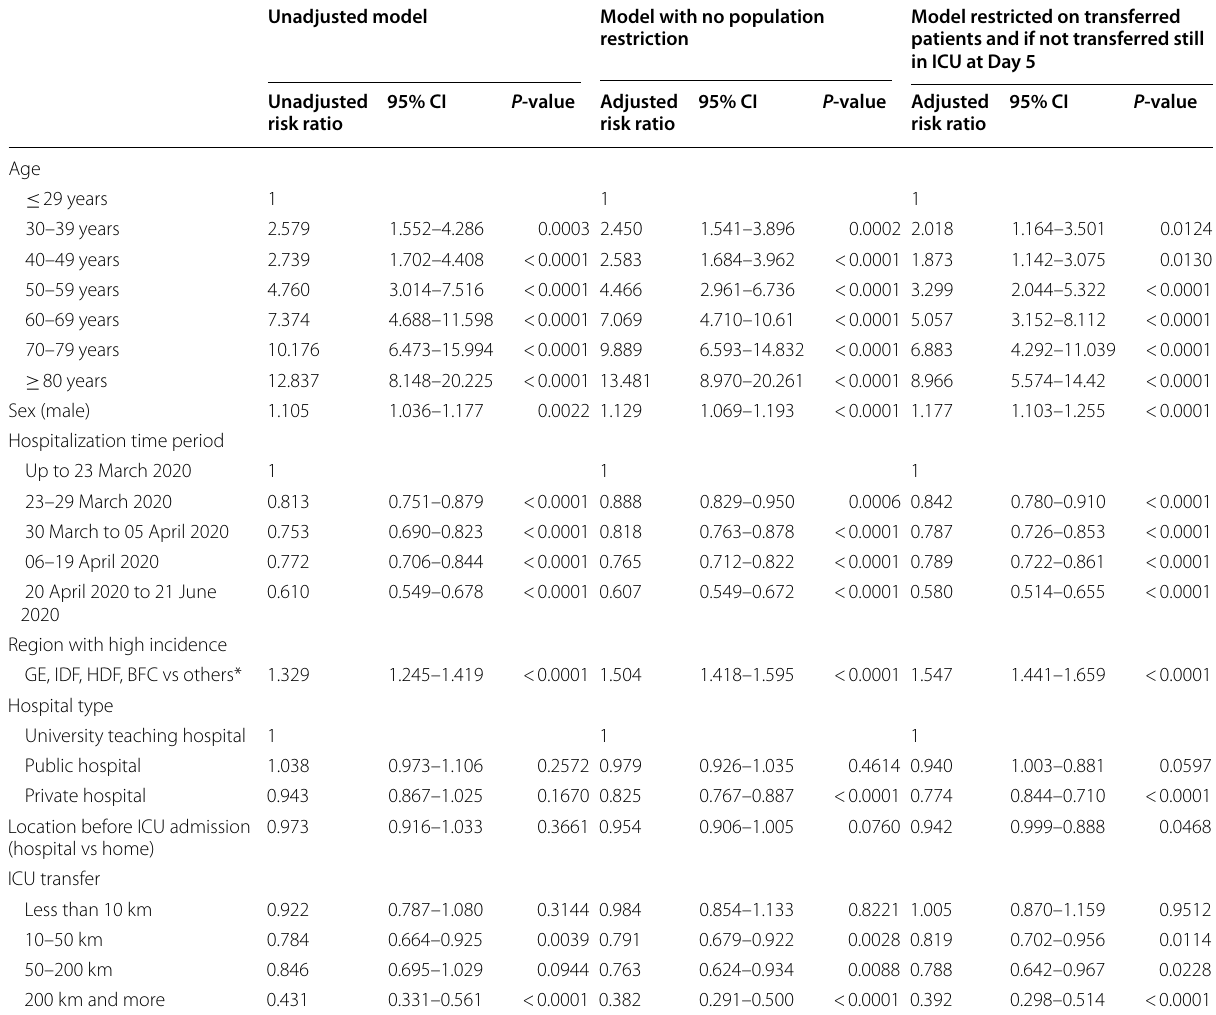
Table 2 Univariate and multivariate mortality models of patients with COVID‑19 hospitalized at the intensive care unit (ICU) in